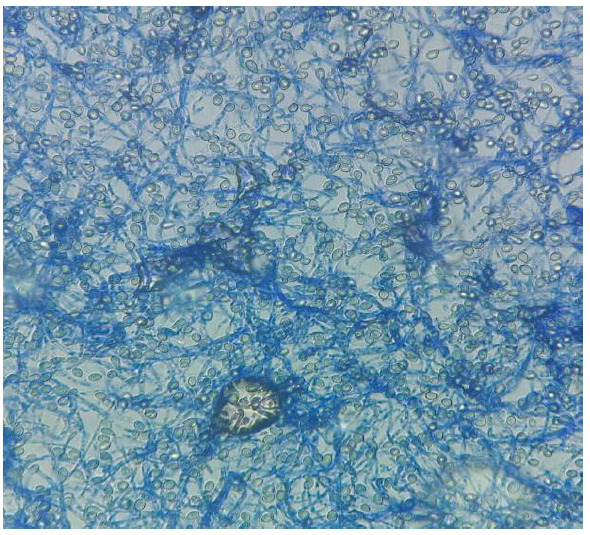
 Microscopic examination of the slide culture stained with lactophenol cotton blue staining and branching septated hyphae and ovale sesile conidia